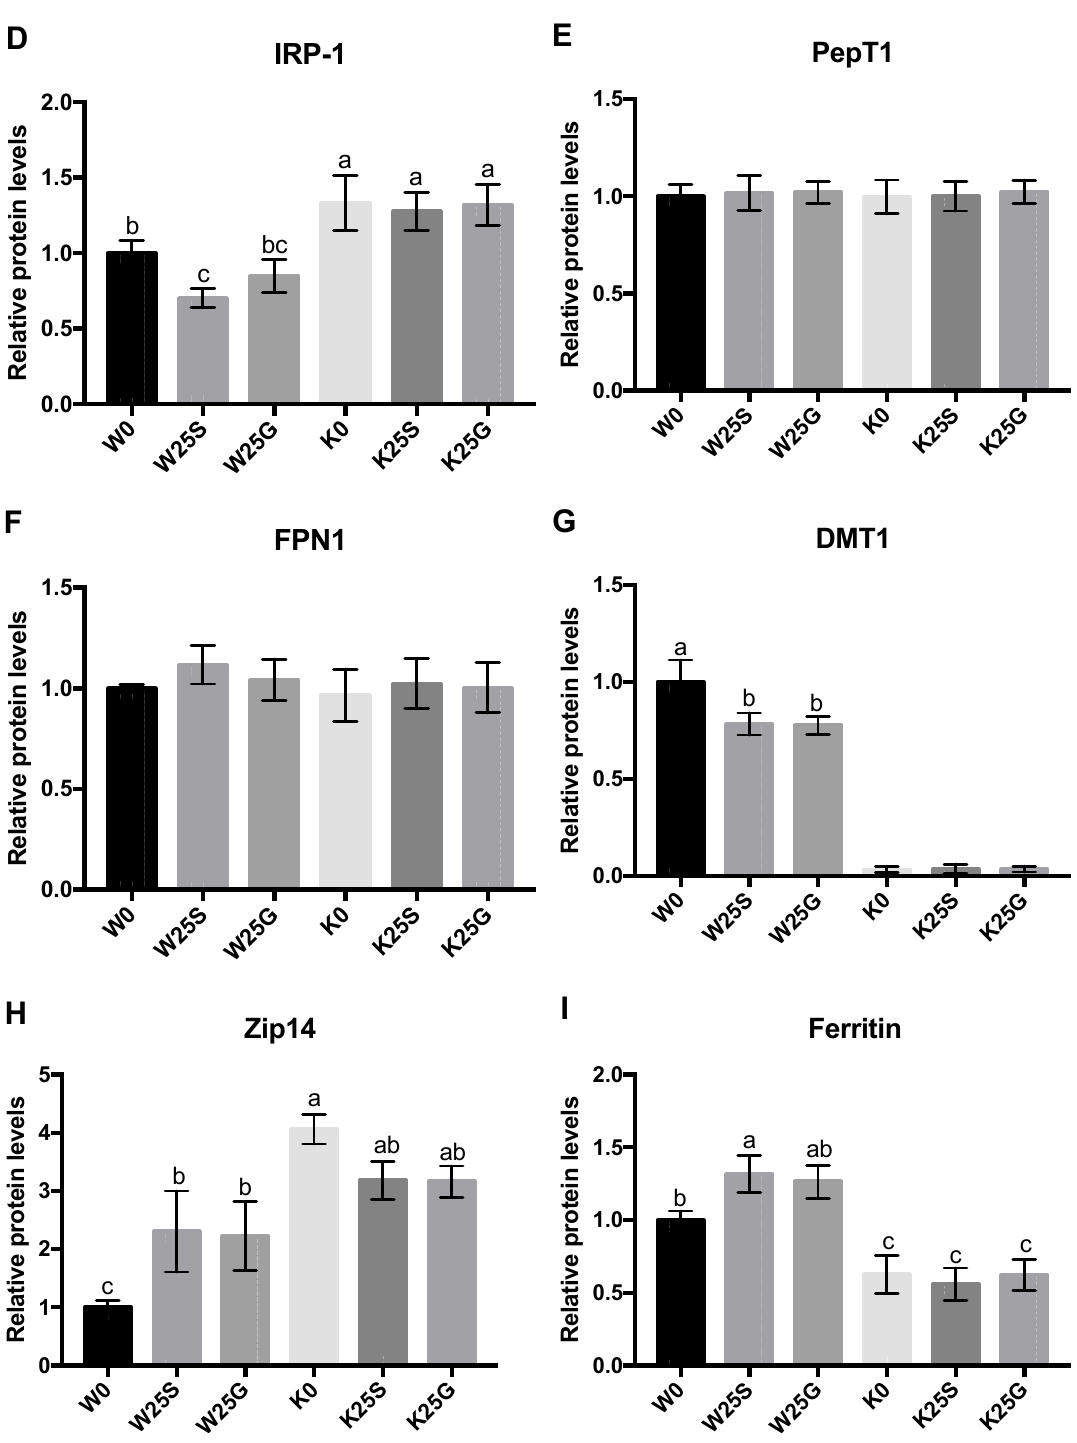
Figure 5. Expression of some iron regulators and transporters after treated with 25 µ M of different iron sources for two hours. Values not sharing a common letter differ significantly ( p < 0.05). W: wild-type cells treated with 0 µ M iron; W25S, W25G: wild-type cells treated with 25 µ M FeSO 4 , 25 µ M Fe-Gly; K0: DMT1-knockout cells treated with 0 µ M iron; K25S, K25G: treated with 25 µ M FeSO 4 , 25 µ M Fe-Gly. ( A ) Western blot bands of iron regulators and transporters. Statistical analysis of ( B ) hypoxia-induced factor-2 α (HIF-2 α ), ( C ) iron regulatory protein 1 (IRP-1), ( D ) IRP-2, ( E ) peptide transporter 1 (PepT1), ( F ) ferroportin 1 (FPN1), ( G ) DMT1, ( H ) iron-regulated transporter (IRT)-like protein 14 (Zip14), ( I ) ferritin expression.